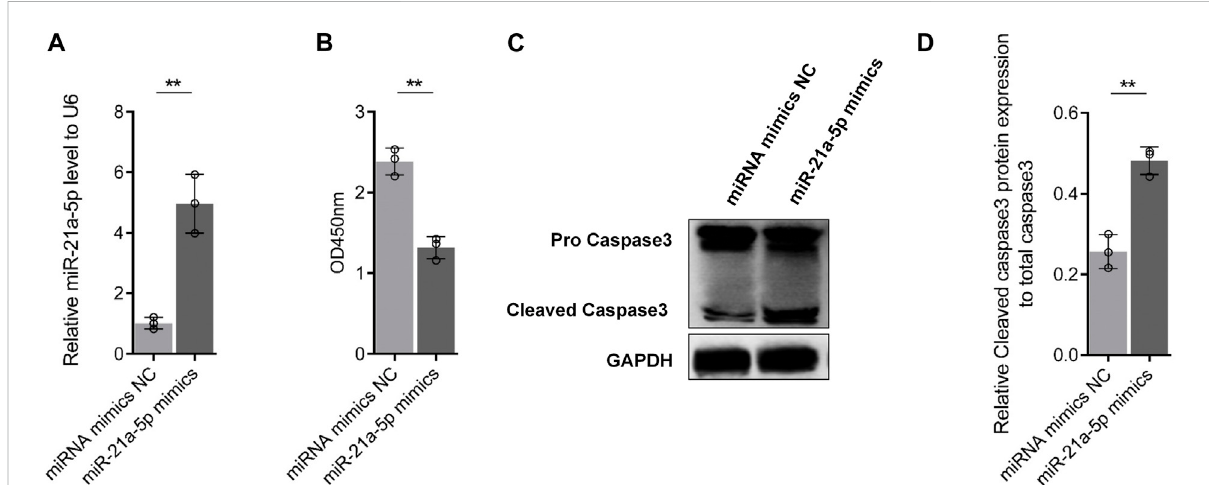
FIGURE 7 EffectofmiR-21a-5ponpodocyteinjury. (A) EffectofmiR-21a-5pmimicstransfectiononthecontentofmiR-21a-5pinMPC5cells. (B) Effectof miR-21a-5p mimics transfection on MPC5 cell viability. (C-D) Effect of miR-21a-5p on the cleavage of apoptotic protein caspase-3 in MPC5 cells. Data analysis adopts Student ’ s t -test. SD indicates error bars. * p < 0.05 and ** p <